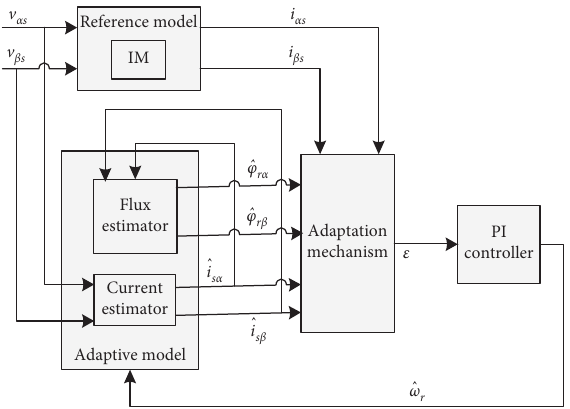
Figure 2: General block diagram of the stator current-based MRAS speed estimator.